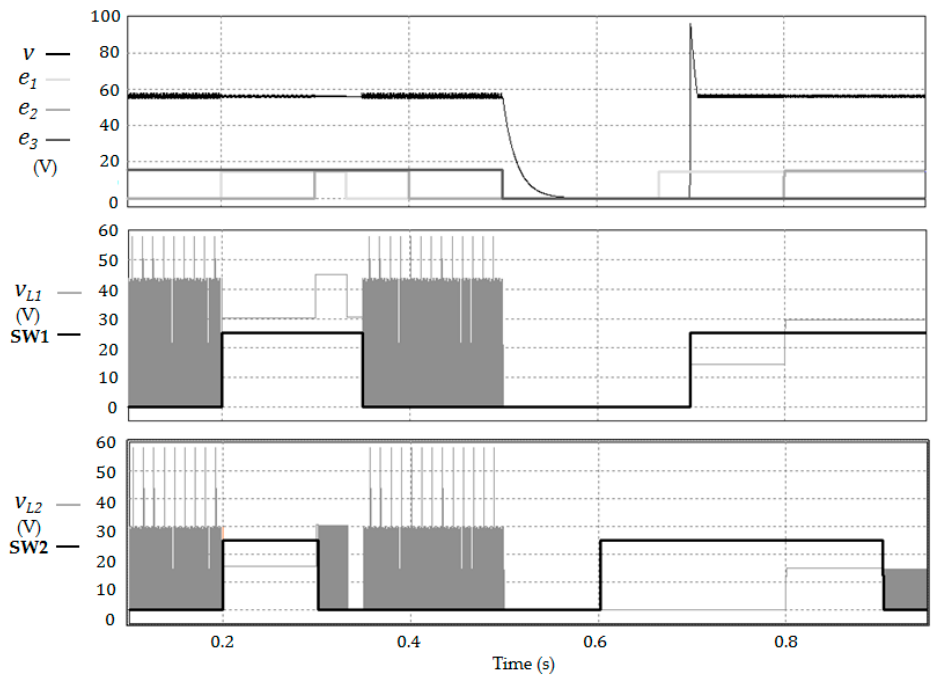
Figure 6. PI closed-loop behavior under several failure events. SW1 and SW2 indicates zero for open circuit and one for normal operation of inductors L 1 and L 2 respectively.